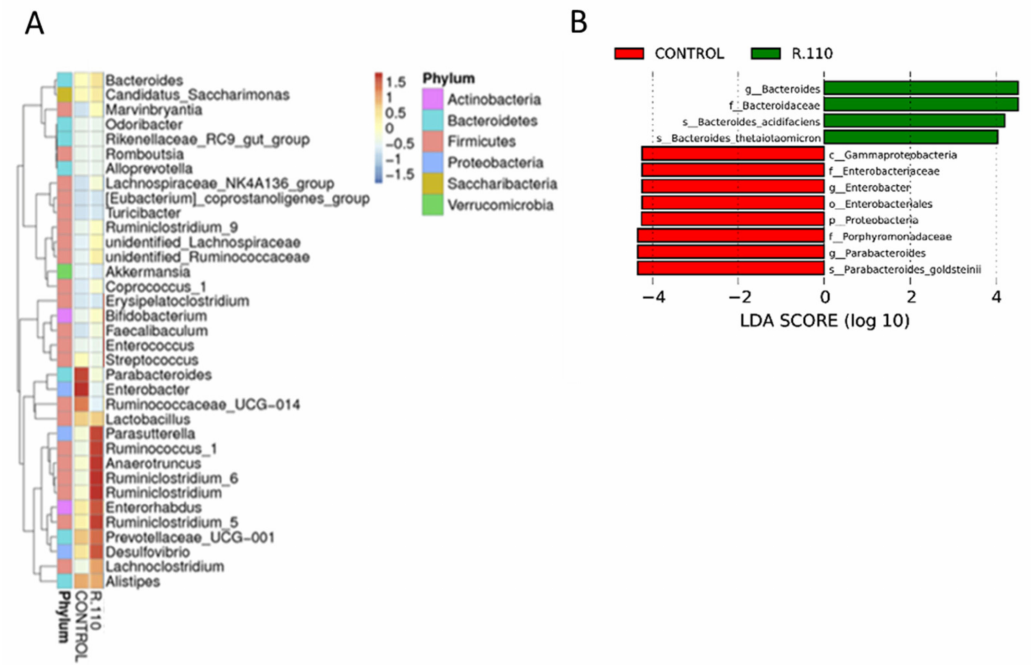
Figure 6. Protection of the gut microbiome by SlpA. Fecal DNA was isolated from Rag1 − / − mice 8- weeks after T cell- mediated colitis initiation. Amplicons were generated using specific primers for V3 and V4 regions of the 16sRNA gene. The amplicon was sequenced using an Illumina high-throughput sequencer with a paired-end sequencing strategy. ( A ) Phylum- wise genera were clustered to show the differential accumulation of bacterial genera in the different treatment groups. ( B ) Linear discriminant analysis (LDA) shows the genus and species of the bacteria that are differentially present between the mice fed with R110 or PBS; n = 5–7